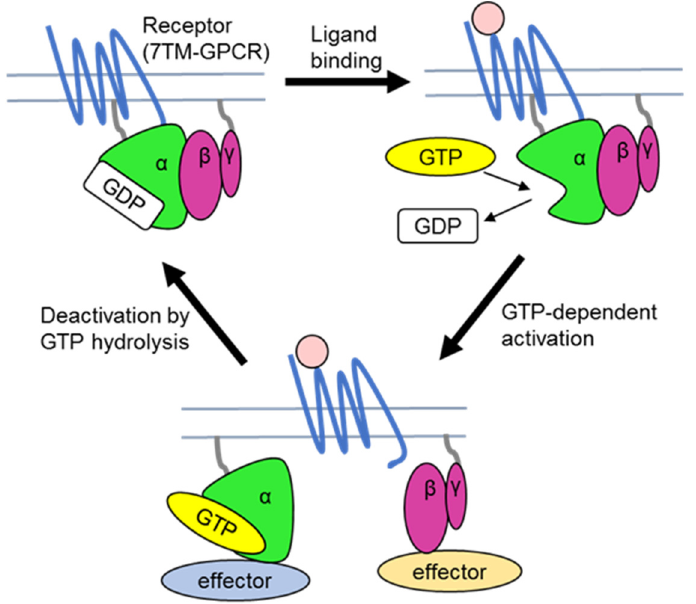
Figure 1. The classic paradigm of heterotrimeric G protein signalling cycle . The heterotrimer consisting of GDP-bound G α and the G βγ dimer is associated with a 7TM-GPCR receptor at the plasma membrane in its resting state. Upon ligand binding, GPCR induces a conformational change in G α , resulting in GDP release followed by GTP binding. GTP-bound G α separates from G βγ , and each interact with their cognate effectors to modulate downstream signalling. The intrinsic GTPase activity of G α leads to GTP hydrolysis, thereby terminating signalling and returning the heterotrimer to the inactive state.